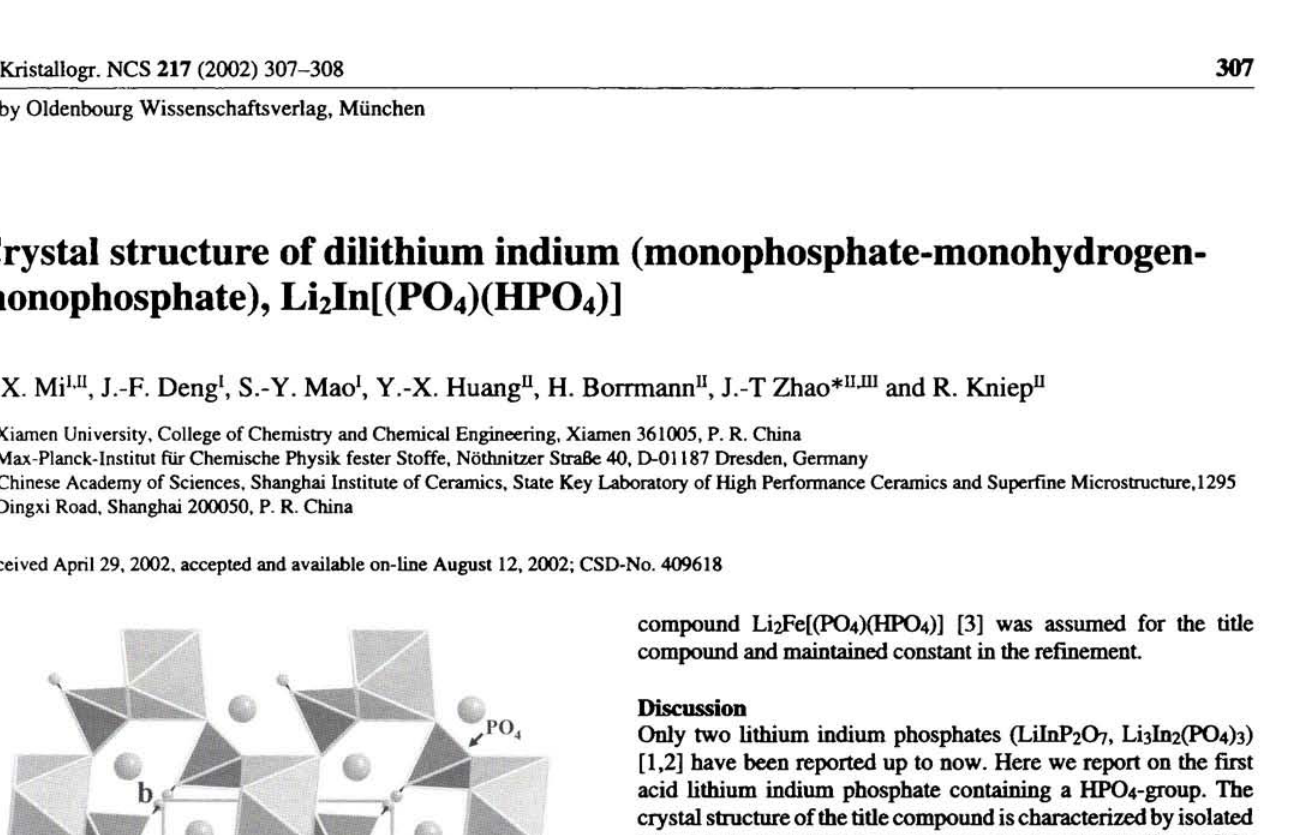
Table 1. Data collection and handling. Crystal: